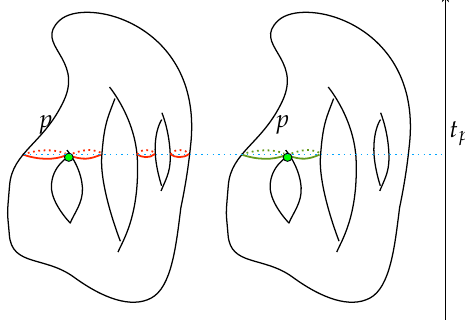
Figure 4. For t p a critical value, on the left, the set f − 1 ( t p ) consists of a singular set C p and two of simple closed curves. On the right, only the critical set C p is shown, which is the connected component of f − 1 ( t p ) that contains the critical point p .